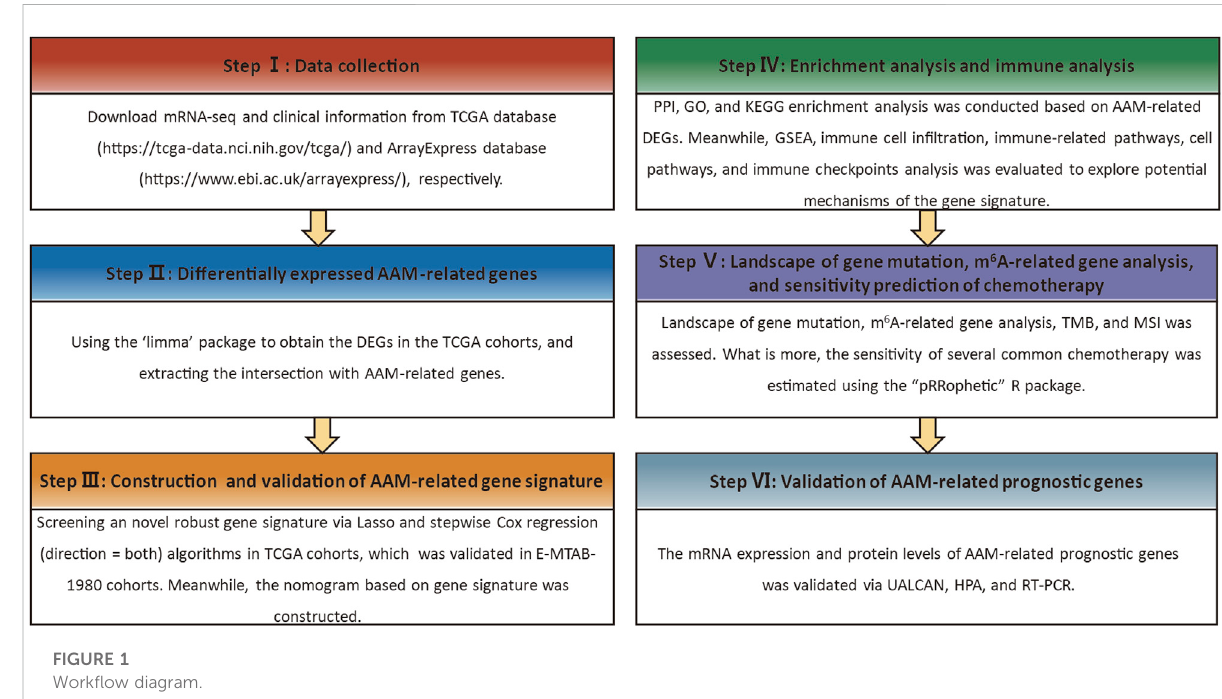
FIGURE 1 Work fl ow